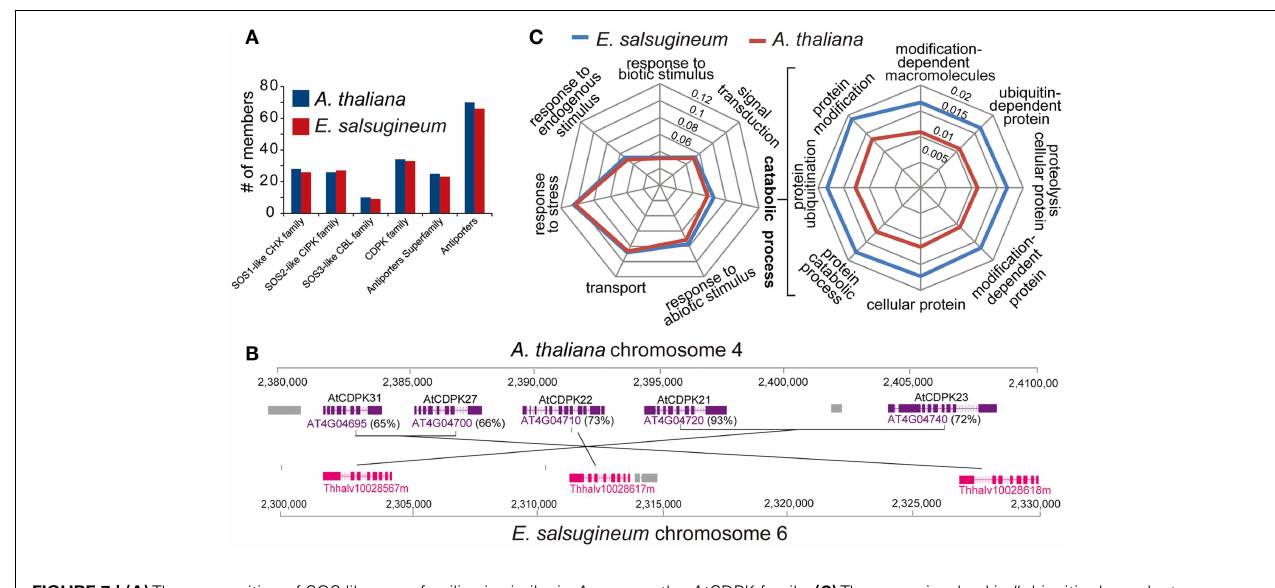
FIGURE 7 | (A) The composition of SOS-like gene families is similar in A. thaliana and E. salsugineum . (B) A genomic region on At Chr4 shows two tandem duplication events in A. thaliana increasing the gene dosage of